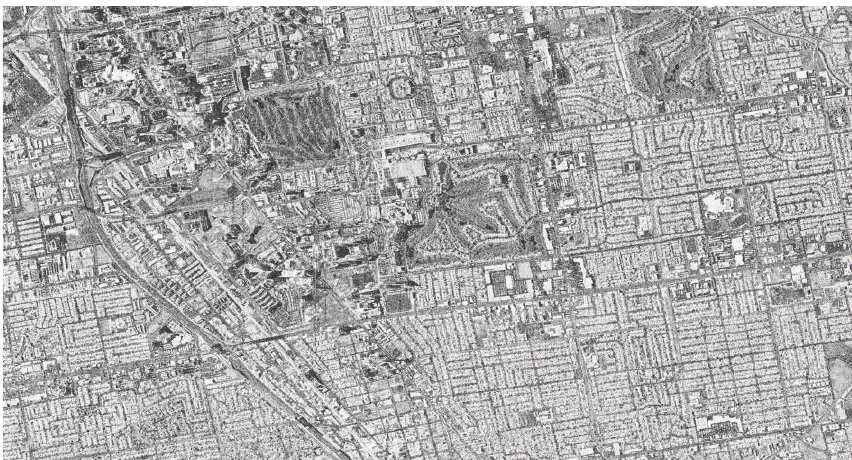
Figure 15: TanDEM-X coherence image. The brighter the more coherent. Parks and water become visible due to the effects of wind.